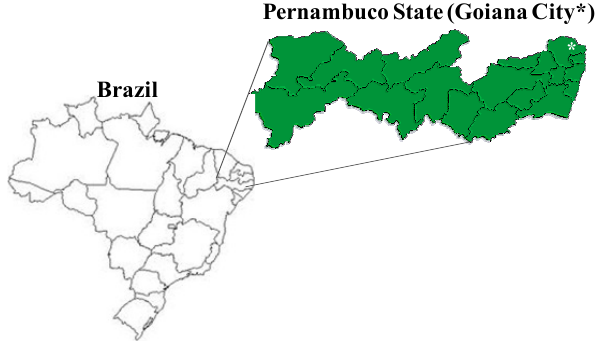
Table 1. Texture, bulk density and water content at the sampling